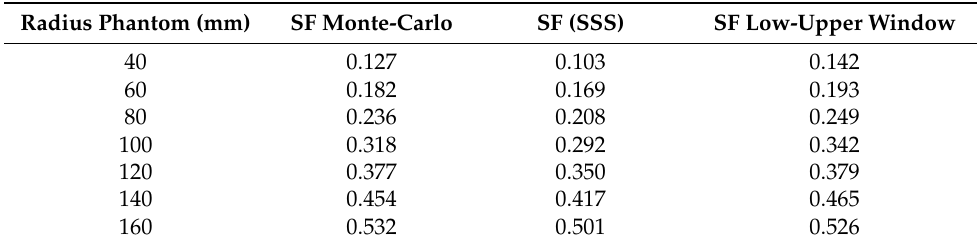
Table 3. Scatter fraction obtained by Monte Carlo simulations, by SSS method, and by the proposed method. A water cylinder with different radii and the same activity source was simulated. Radius Phantom (mm) SF Monte-Carlo SF